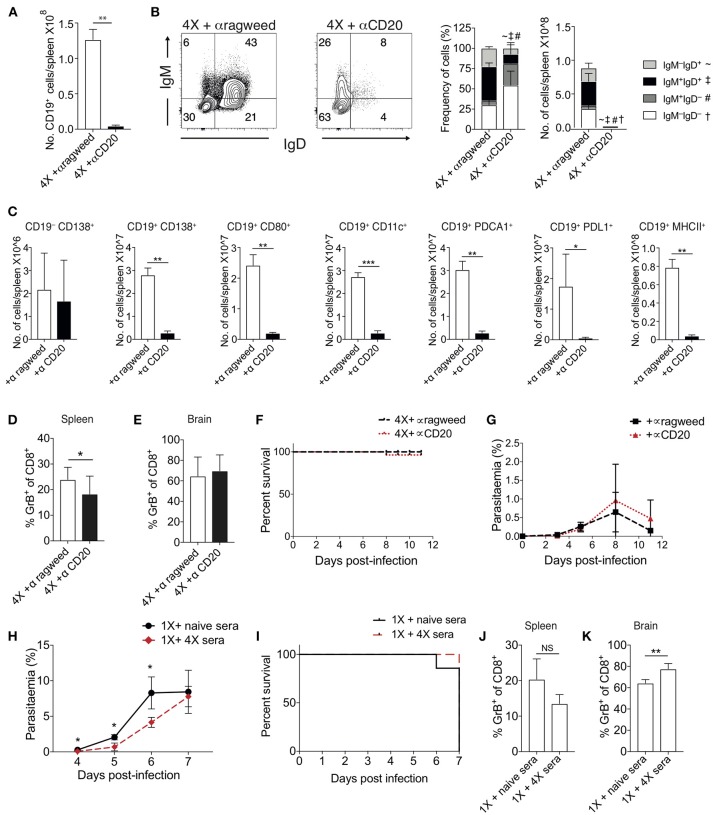
Ablation of B cell populations or transitory boosting of anti-parasite antibody does not alter dynamics of ECM in 1X or 4X infected mice. (A–G) C57BL/6 mice were injected (i.p) one day prior to 4X infection and on days 2, 5, 8, 11 of infection, with either (250 μg) anti-CD20 mAb or (250 μg) control anti-ragweed mAb. (A) Total numbers of splenic CD19+ B cells. (B) Left, Representative flow cytometric plots (gated on live CD45+CD3−CD19+ cells), right, the frequencies of non-switched (IgM+IgD+ and IgM−IgD+) and switched (IgM+IgD−, and IgM−IgD−) splenic CD19+ B cells. (C) Total numbers of splenic CD19− CD138+ plasma B cells and splenic CD19+ B cells expressing CD138, CD80, CD11c, PDCA1, PDL-1, and MHC II in 4X infected mice that received anti-CD20 mAb or anti-ragweed mAb. (D,E) The frequencies of Granzyme B expressing CD8+ T cells in the (D) spleen and (E) brain in 4X infected mice that received anti-CD20 mAb or anti-ragweed mAb. (F) Survival of 4X infected mice given anti-CD20mAb or control mAb. (G) Parasitaemia (% of pRBCs) of 4X infected mice given anti-CD20mAb or control mAb. (H–K) C57BL/6 mice received 500 μl of heat-inactivated plasma (obtained from 4X infected mice or, as a control, from age-matched naïve mice) prior to and during 1X infection (4 i.p. injections between day −1 and day 5 of infection). (H) Peripheral parasitaemia (% of pRBCs) in 4X infected mice that received plasma from 4X or uninfected mice (I) Kinetics of ECM development shown as percentage survival of 1X infected mice that received plasma from 4X or uninfected mice. (J,K) The frequencies of granzyme B expressing CD8+ T cells in the (J) spleen and (K) brain in 1X infected mice that received plasma from 4X or naïve mice. (A–K) Results are the mean ± SD of the group. (A–C)
N = 3–4 per group, representative of two independent experiments. (D,E)
N = 7–8 per group, pooled from two independent experiments. (F, G)
N = 10–13 per group, pooled from two independent experiments. (H, I)
N = 6–7 per group, pooled from two independent experiments. (J,K)
N = 4, representative of two independent experiments. Statistical analyses were performed with by Student's t-test, with Welch's correction or Mann-Whitney test depending on normality of data (*p ≤ 0.05, **p ≤ 0.01 ***p ≤ 0.001 and p < 0.05 denoted by #, ~, ‡ for indicated groups).